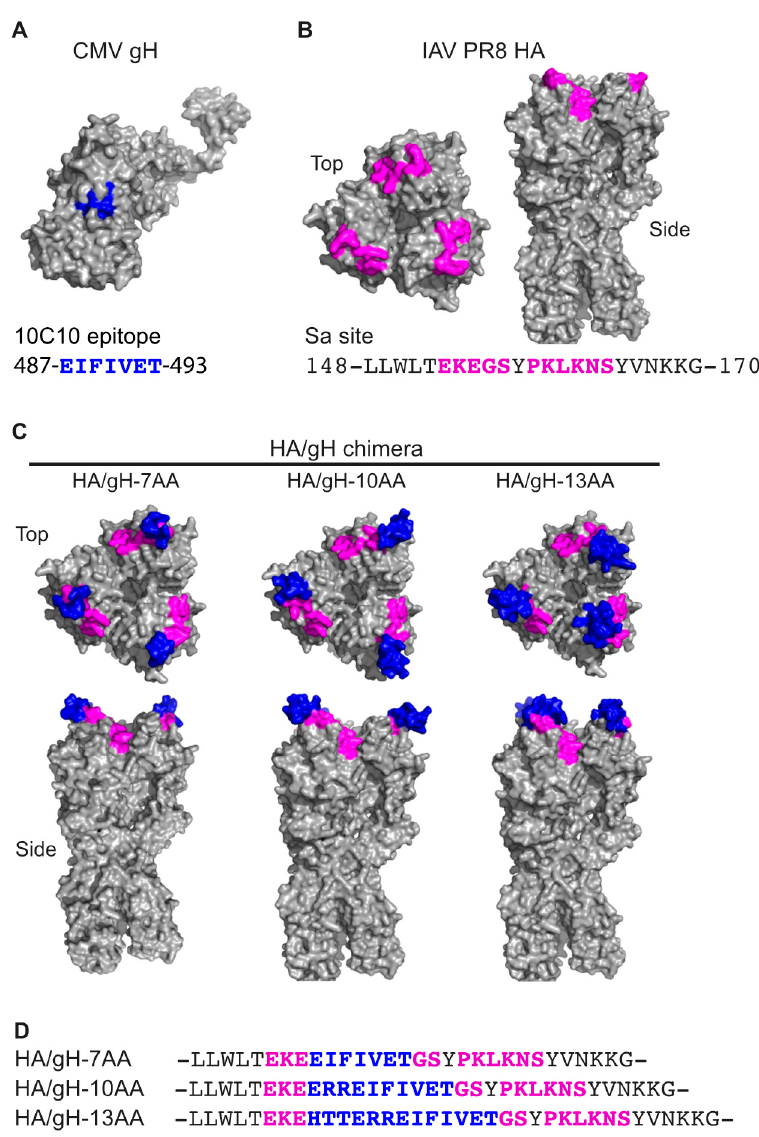
Figure 1. Model of the chimeric influenza hemagglutinin (HA) / CMV gH molecules. ( A ) Predicted structure of the CMV gH protein. Blue color indicates the mAb 10C10 recognition epitope. ( B ) Predicted structure of influenza A virus (IAV) PR8 HA trimer (PDB3LZG) (top view and side view) with the classically defined antigenic site Sa colored in pink. The AA numbering is based on Burke Reference Sequence Alignment for PR8 [43]. ( C ) Predicted structures of chimera HAs containing CMV gH epitope (7AA, 10AA, or 13AA, in blue) within Sa antigenic site (in pink). Modeling performed with PyMOL (The PyMOL Molecular Graphics System, Version 2.0.1, Schrödinger, LLC) [44]. Amino acids in gray are unchanged. ( D ) Amino acid sequences of the Sa antigenic site (in pink) of chimera IAVs (A / Puerto Rico / 8 / 1934(H1N1)) with CMV gH epitopes (7AA, 10AA, or 13AA, in